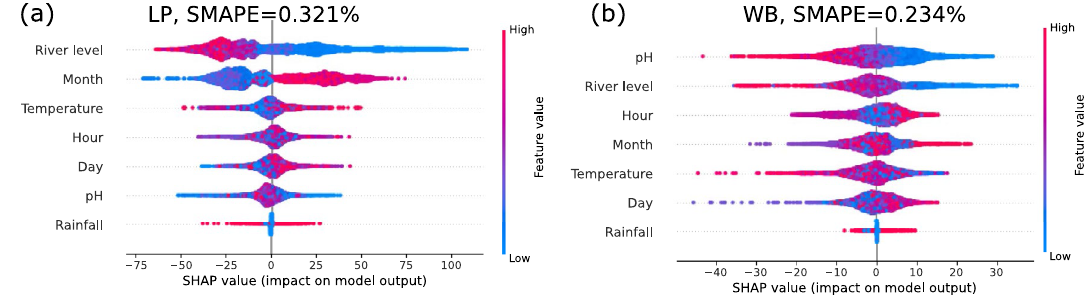
Figure 9. Feature ranking of the boosted tree via SHAP. The features are sorted by their importance in predicting deviations from the mean EC for LP ( a ) and WB ( b ), see also Fig. 8. As in the GAM approach, we report the symmetric mean absolute percentage error (SMAPE) of the model when applied to the test set.